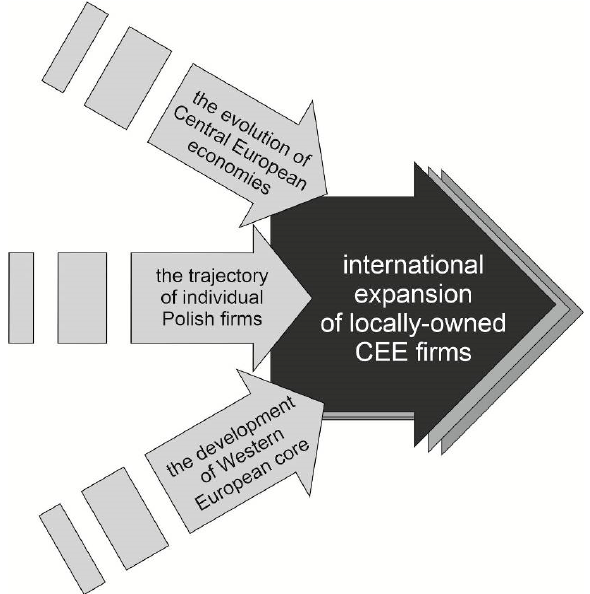
Figure 4. The critical conjuncture of three mechanisms giving rise to global expansion of Polish automotive firms. Source: authors’ elaboration.